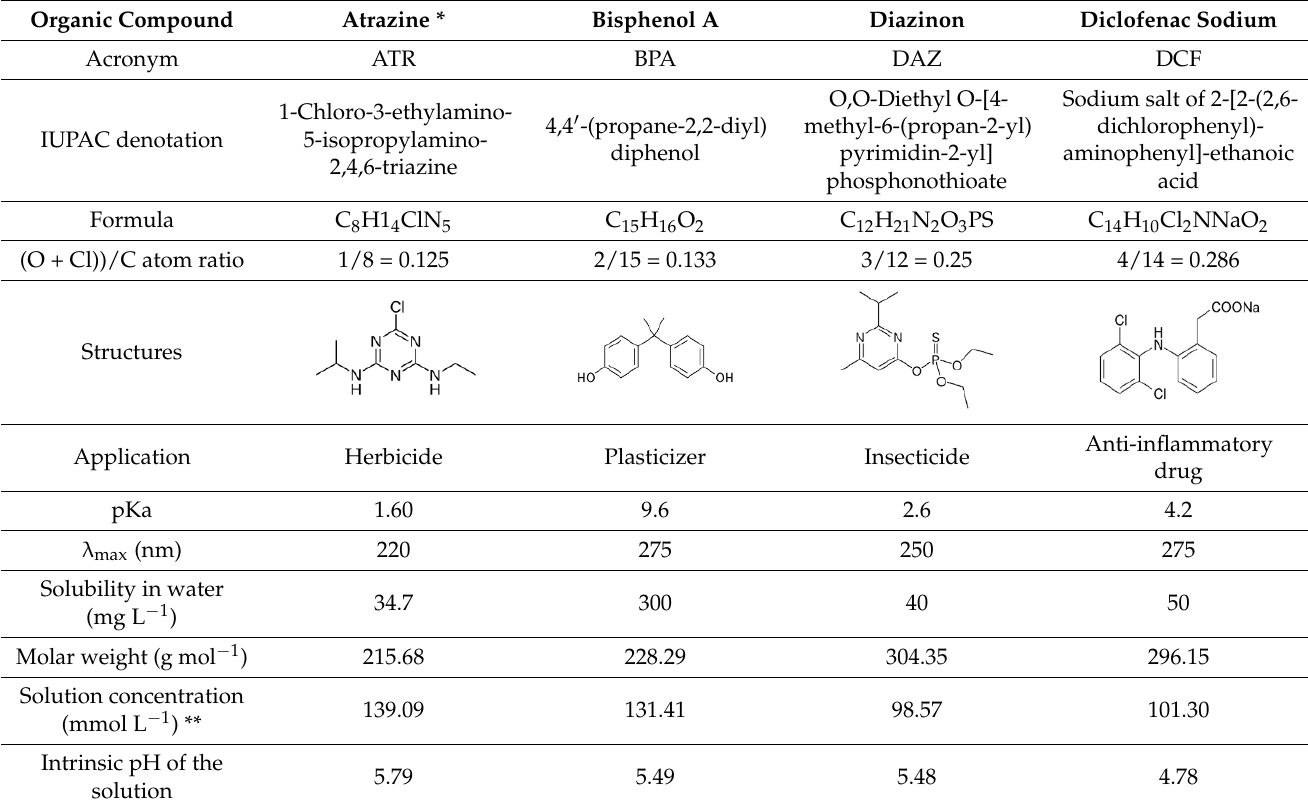
Table 1. Some features of the organic molecules investigated.